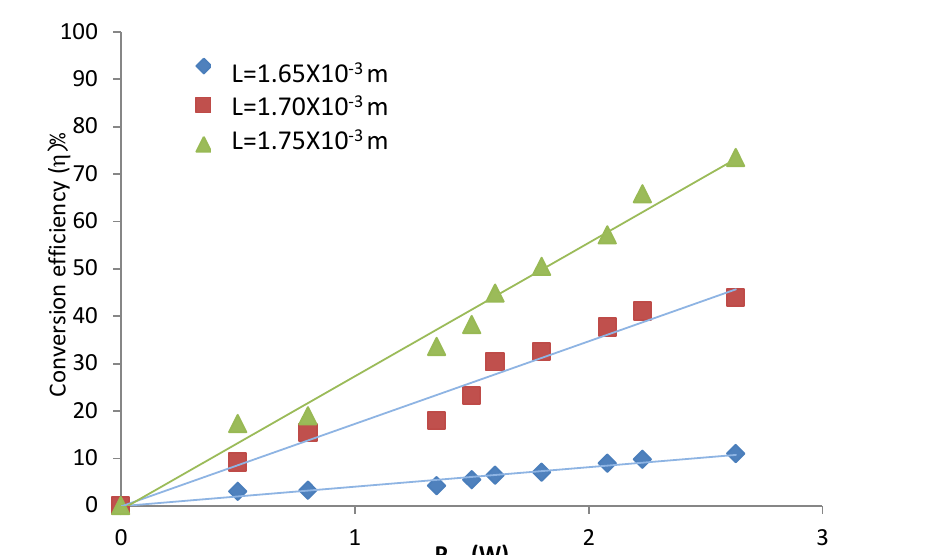
Fig.5: Experimental results of conversion efficiency vs. incident power (W) at different length of nonlinear crystal and at